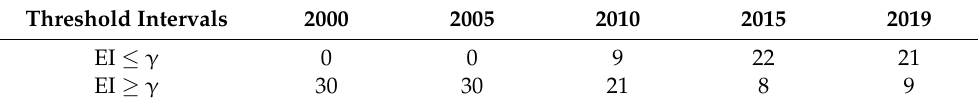
Table 3. Number of provinces in different EI intervals, 2000–2019. Threshold Intervals